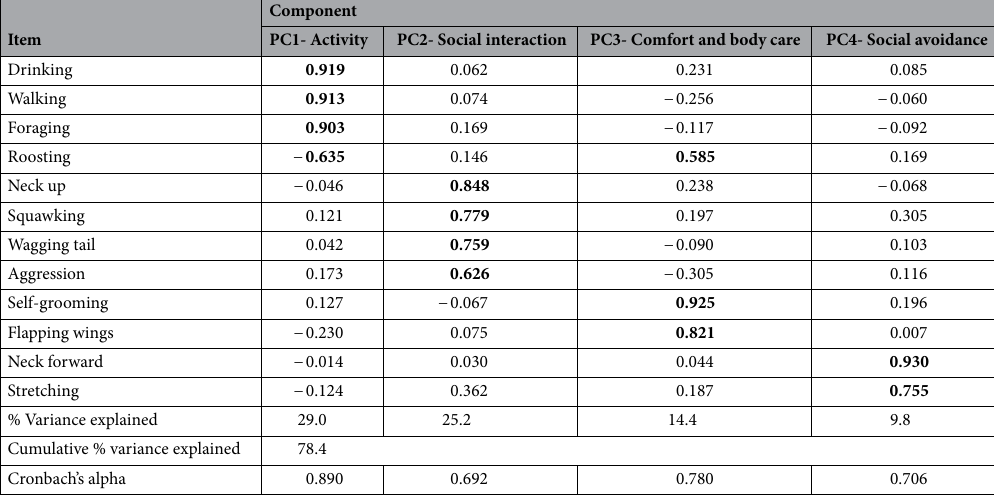
Table 3. Loadings of behavioral variables of factors extracted with the principal component analysis. Loadings with an absolute value greater than 0.5 are in